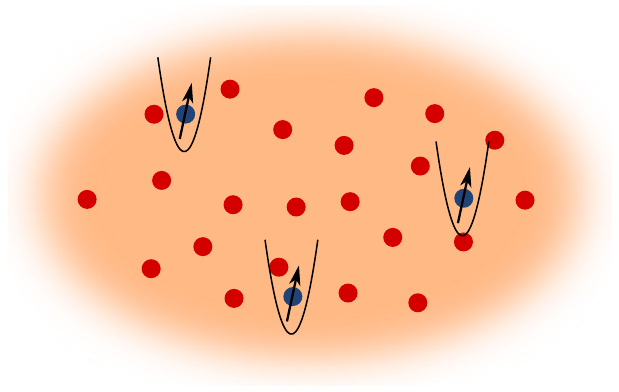
FIG. 1. Proposed experimental setup: Impurity atoms (blue dots with arrows, indicating internal states) are immersed in a sea of itinerant host fermions (red dots). The optical lattice, indicated by the black parabolas, localizes the impurity atoms without affecting the itinerant host fermions. We assume a low concentration of impurity atoms, so that we can consider scat- tering on a single impurity. The scattering of fermions can be controlled by applying magnetic fields and by manipulating the internal impurity states with RF pulses. The system’s parameters can be controlled quickly (compared to the intrinsic time scales of the many-body system of host fermions), which makes this setup ideal for studying nonequilibrium impurity physics, in- cluding the new regimes of the